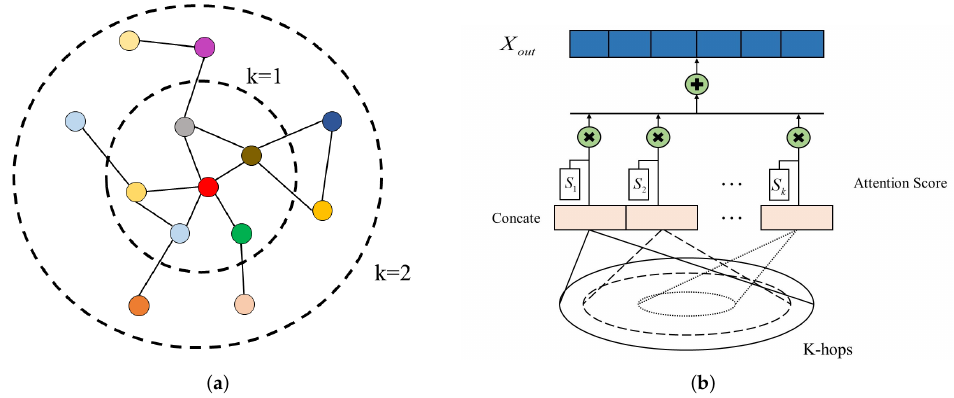
Figure 3. An illustration of the proposed adaptive graph convolution module. This module can adaptively adjust the node neighborhood size according to the application. ( a ) K-hop neighbor nodes, ( b ) adaptive neighborhood size